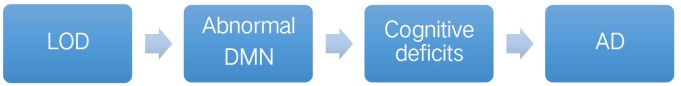
Default mode network (DMN) might be the neural basis for linking LOD with AD. LOD, late-onset depression; DMN, default mode network; AD, Alzheimer’s disease.